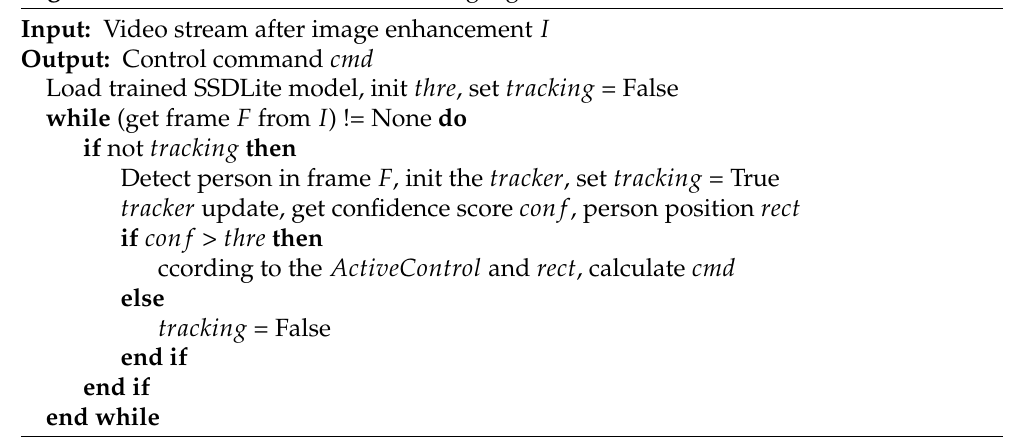
Algorithm 1 Underwater human tracking algorithm